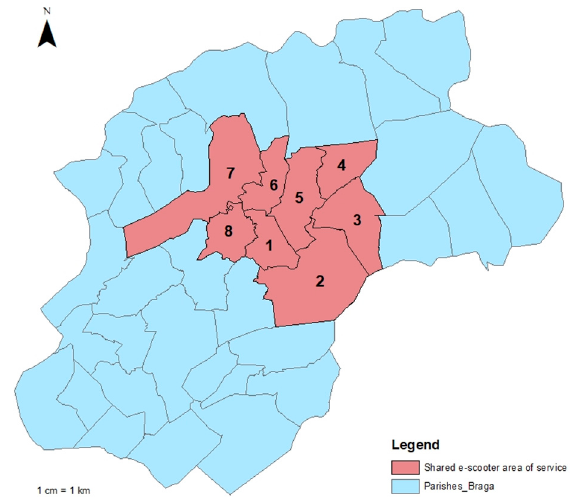
Figure 3. Area served by shared e-scooters in Braga.